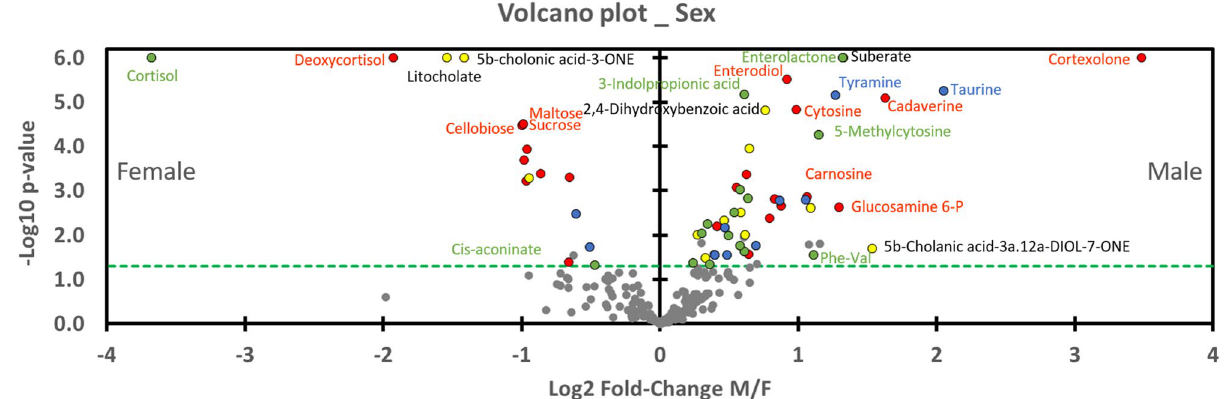
Figure 4. Volcano plot showing metabolomic data in rats (n = 57) according to the gender. Fecal metabolites over-expressed in males are on the right and those of female rats are on the left. The dashed line shows where p = 0.05 with points above the line having p < 0.05 and points below the line having p > 0.05. Colors of the dots are in accordance with the Venn diagram and whose significance is true according to the 2-way ANOVA. Red dots are for Sex*Strain*Interaction, for example. Grey dots are not significant according to the 2-way ANOVA and the post-hoc